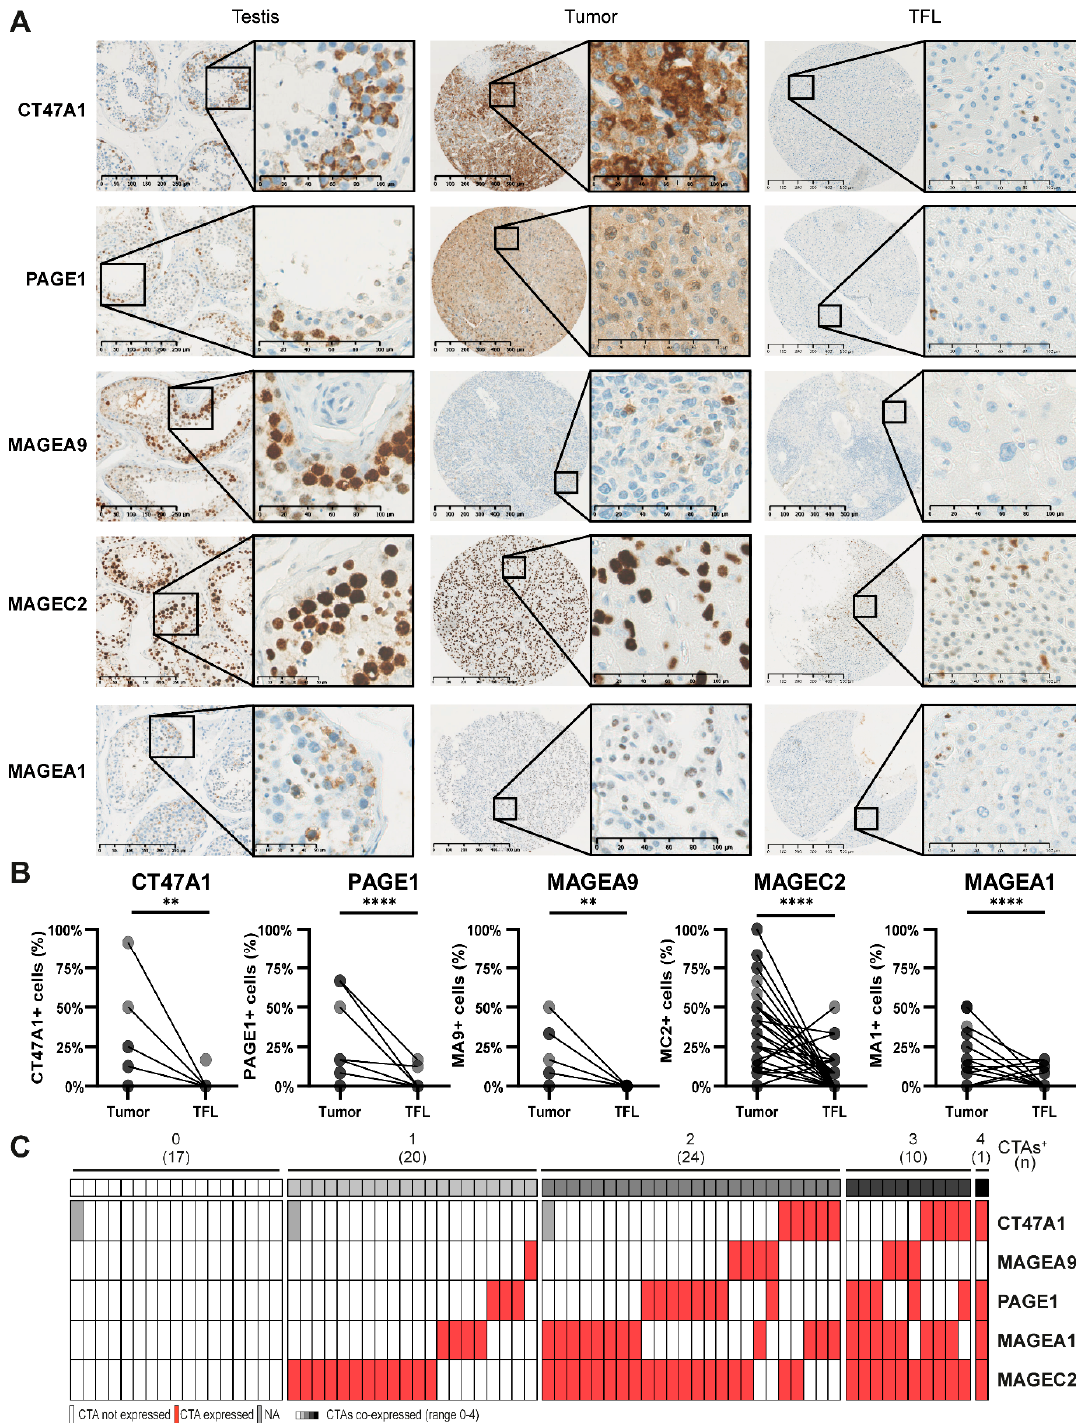
Figure 3. Proteins CT47A1, PAGE1, MAGEA9, MAGEC2, and MAGEA1 are expressed in HCC tumors and TFL. TMAs of tumor and TFL tissues were immunohistochemically stained to study the protein expression of aforementioned CTAs. ( A ) Representative examples of immunohistochemical stains in testis, a positive HCC tumor tissue and TFL tissue. ( B ) Scores of percentages of tumor cells or hepatocytes expressing CT47A1, PAGE1, MAGEA9, MAGEC2, and MAGEA1 in tumors and paired TFL ( n = 78). Average scores of three tissue cores are shown. Wilcoxon signed-rank test, ** p < 0.01, **** p < 0.0001. ( C ) Heatmap indicating co-expression of CTA-proteins in tumor tissue. TMA slides were scanned by a Nanozoomer (Hamamatsu, Hamamatsu, Japan), and analyzed by NDP.view2 software (Hamamatsu).